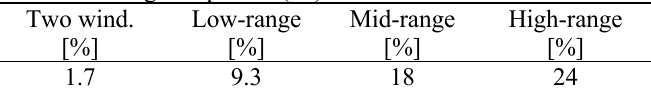
Table 10: The maximum errors of Jenei’s formula for the layout shown in Fig. 2, with 𝑙 evaluated accord- ing to equation (32).